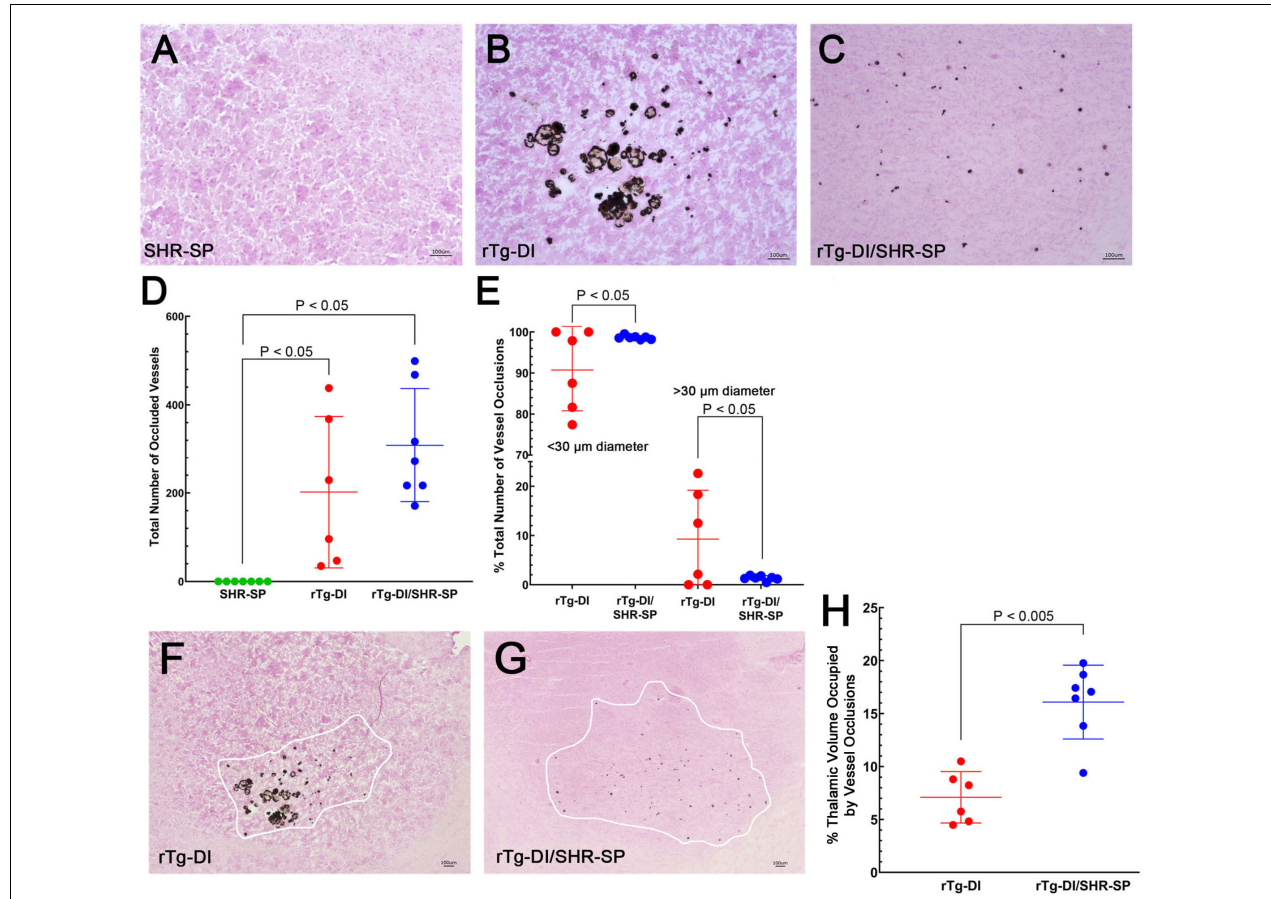
FIGURE 10 | Thalamic small vessel occlusions in 10 M rats. Representative images of 10 M brain sections of SHR-SP (A) , rTg-DI (B) , and bigenic rTg-DI/SHR-SP (C) rats showing thalamic calcified, occluded vessels. Scale bars = 100 µ m. (D) Total number of thalamic occluded vessels in SHR-SP ( n = 7) in green, rTg-DI ( n = 6) in red and bigenic rTg-DI/SHR-SP ( n = 7) in blue (D) . Data presented are the means ± S.D. Significant differences were found by one-way ANOVA between SHR-SP and rTg-DI ( P < 0.05) and between SHR-SP and bigenic rTg-DI/SHR-SP ( P < 0.05). (E) The percentage of total thalamic vessel occlusions < or > 30 µ m in diameter in rTg-DI ( n = 6; red) and bigenic rTg-DI/SHR-SP ( n = 7; blue). Data presented are the means ± S.D. Unpaired t -test shows an increase in the percentage of thalamic vessel occlusion diameters < 30 µ m or > 30 µ m in bigenic rTg-DI/SHR-SP compared to rTg-DI ( P < 0.05). Lower magnification representative images of 10 M brain sections of rTg-DI (F) and bigenic rTg-DI/SHR-SP (G) rats showing the range of thalamic calcified, occluded vessels. White tracings depict the borders of small vessel occlusions in thalamus. Scale bars = 100 µ m. (H) The percent thalamic volume presenting with small vessel occlusions in rTg-DI ( n = 6) in red and bigenic rTg-DI/SHR-SP ( n = 7) in blue. Data presented are the means ± S.D. Unpaired t- test shows a significant increase in thalamic volume with small vessel occlusions in bigenic rTg-DI/SHR-SP rats compared to rTg-DI rats ( P < 0.005). Together, these data indicate that the number of thalamic vessel occlusions does not change with the introduction of the rTg-DI transgene onto the SHR-SP background, although there is a change in size and extent of spatial distribution of these vessel occlusions in the